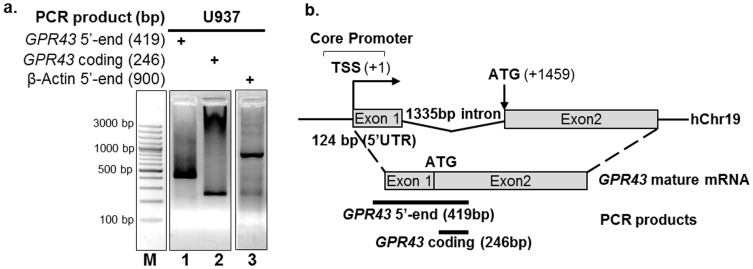
The GPR43 transcription start site is mapped to 1459 bp upstream of the ATG start codon.(a) 5′-RACE of GPR43 transcripts from U937 cells. Total RNA from U937 cells was extracted and full-length GPR43 mRNA was reverse transcribed using a gene specific primer complementary to its open reading frame. The resulting cDNA was ligated to a known oligonucleotide sequence at the 5′ end. Nested PCR using primers flanking the 5′ end was then performed to procure an approximately 450 bp product encompassing the 5′ untranslated region (5′-UTR) and part of the GPR43 coding sequence (lane 1). As positive controls, amplification of 246 bp of the GPR43 coding region (lane 2), as well as a 900 bp-long 5′ end of the β-actin gene (lane 3) were performed. (b) Schematic mapping the GPR43 5′-UTR region and protein coding region on the human chromosome 19. The PCR product from (a, lane 1) was sequenced to reveal a 124 bp long 5′-UTR exon upstream of the GPR43 ATG start codon.